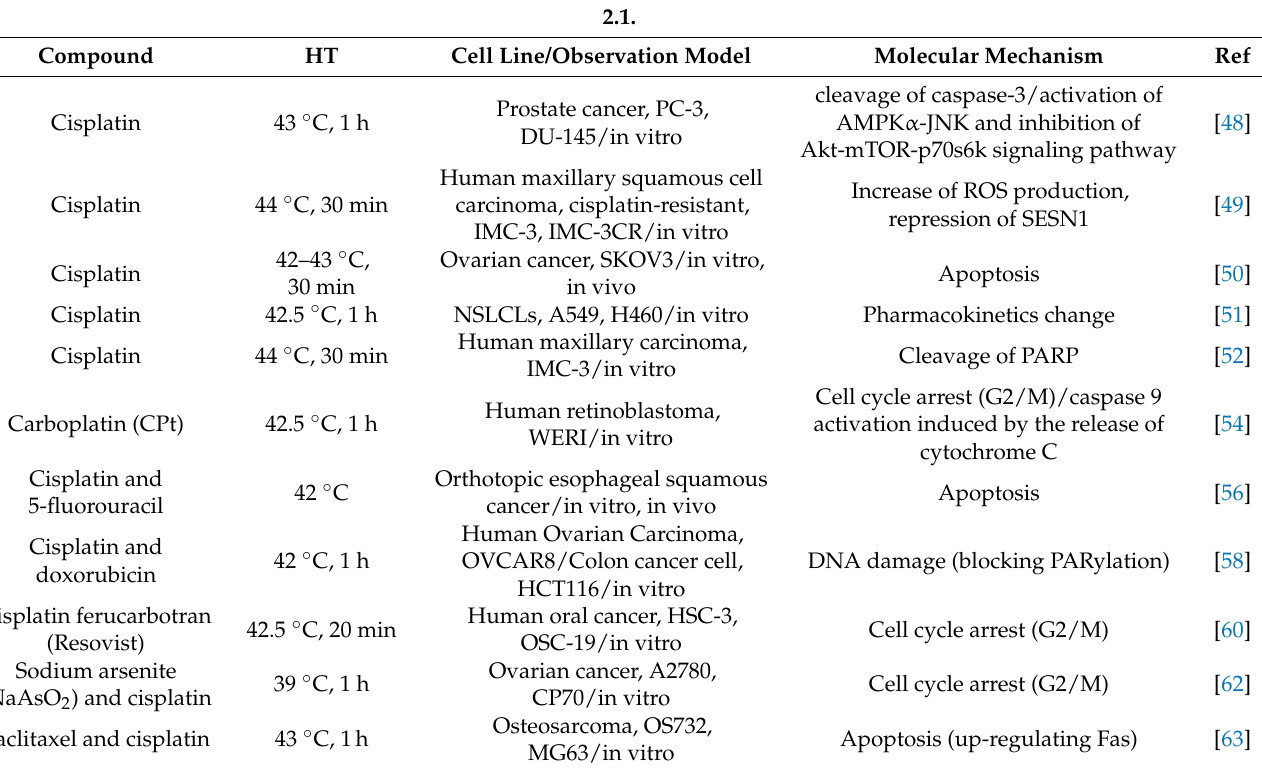
Table 2. 2-1. Sensitizing effect of HT on cisplatin. 2-2. Sensitizing effect of HT on Paclitaxel. 2-3. HT sensitized tumor cells to various anti-cancer agents 1. 2-4. HT sensitized tumor cells to various anti-cancer agents